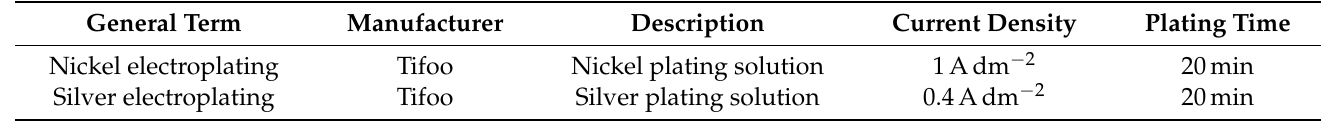
Table 2. Overview of contacting materials tested for the electrodeposition.